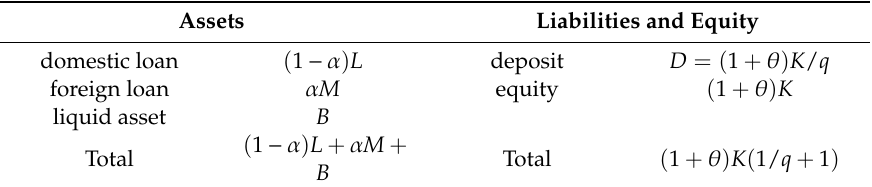
Table 1. The bank’s balance sheet at t = 0.